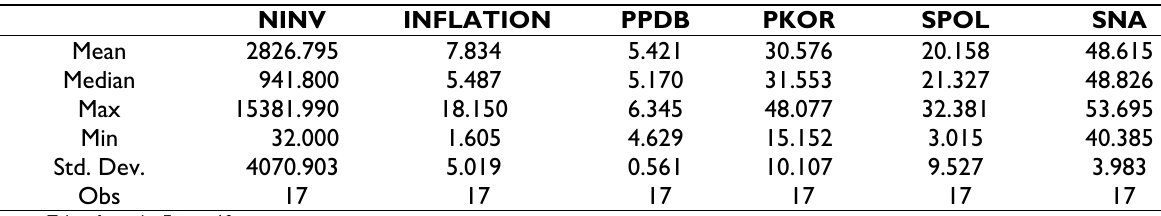
Table 3. Descriptive statistics of research data